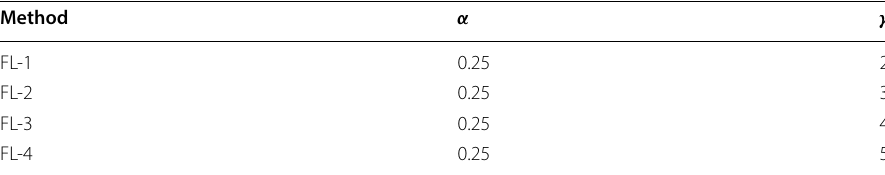
Table 9 Focal loss experiments